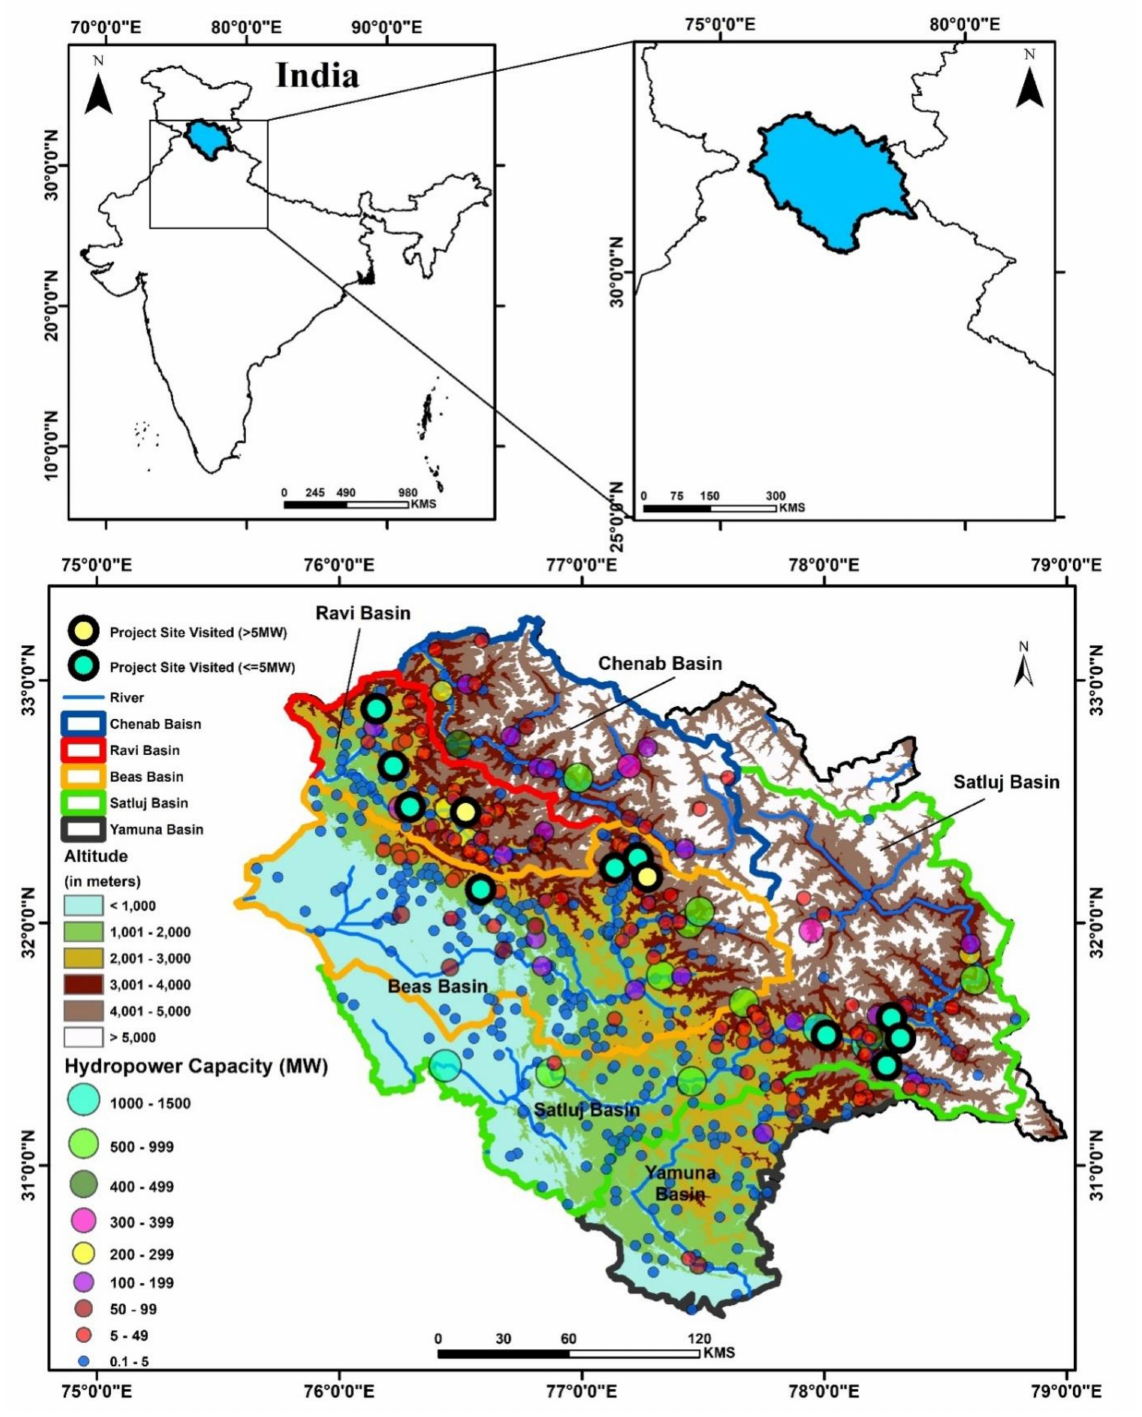
Figure 1. Basin-wise distribution of hydropower projects of all those commissioned and under construction in the Himachal